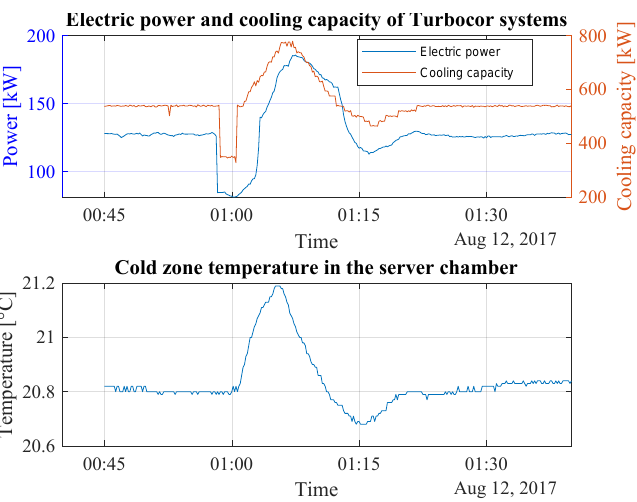
Figure 7. Power consumption and cooling capacity generated as a result of supply voltage col- lapse/cold zone temperature in the server